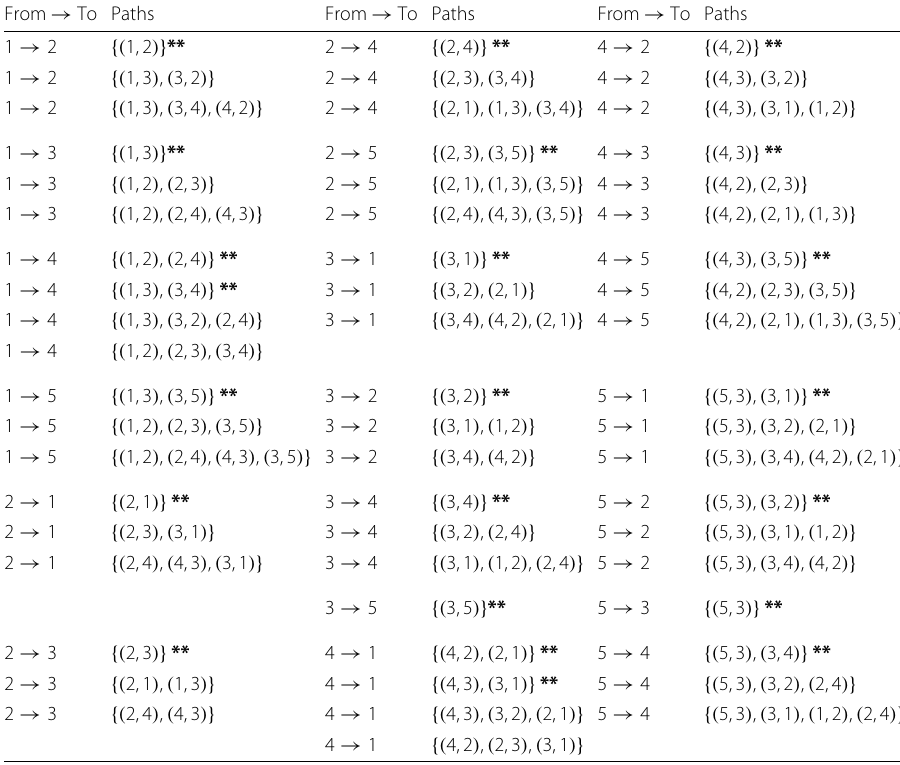
Table 2 Path enumeration for the small example in Fig. 1 From → To Paths From → To Paths From → To